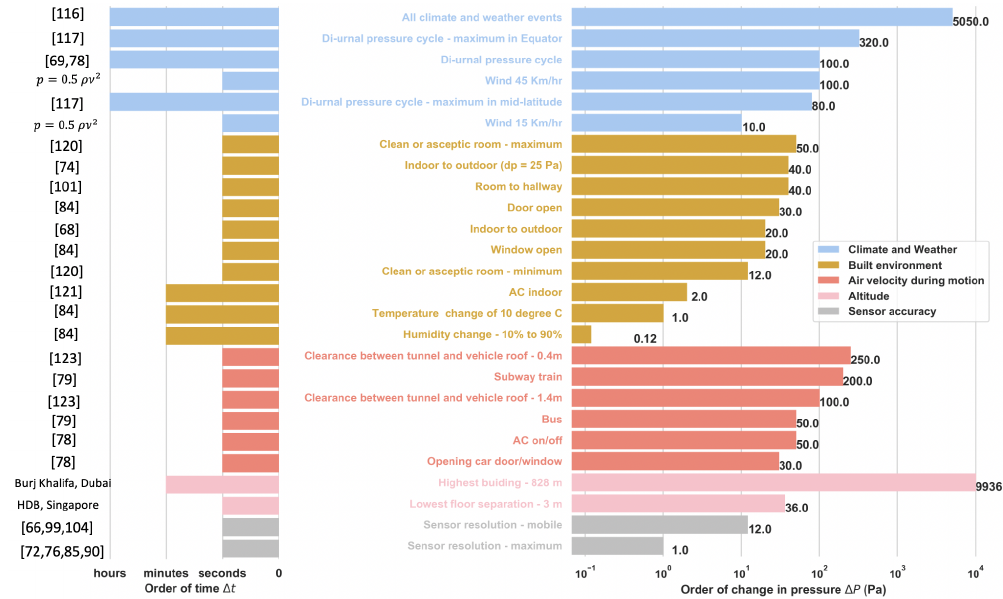
Figure 1. Orders of magnitude of changes in pressure and of the corresponding timescales for several factors influencing barometric